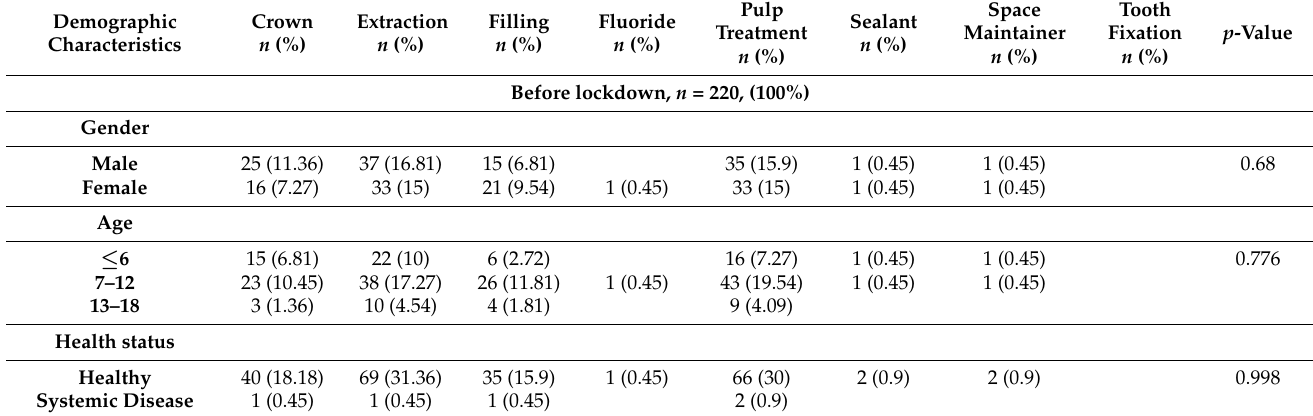
Table 5. Comparison between the demographic characteristics and dental procedures of pediatric patients’ emergency visits before, during, and after the